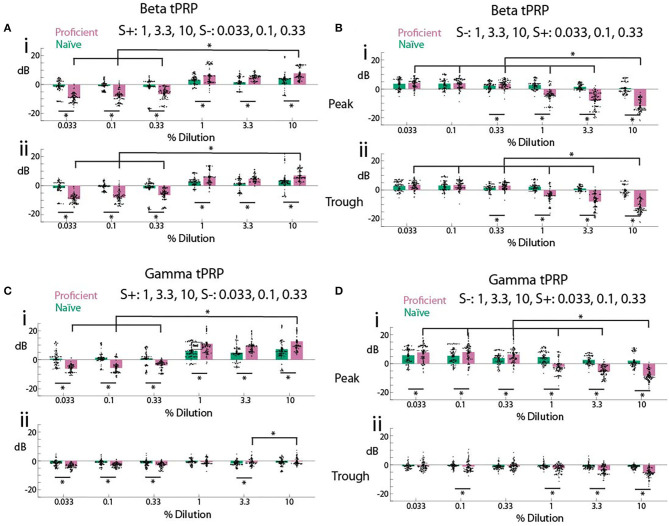
Summary of theta phase-referenced power. (A,B). Beta tPRP. (C,D) Gamma tPRP. Top panels (i) are referenced to the peak of the theta oscillation while bottom panels (ii) are referenced to the trough. (A,C) are tPRP for sessions where the three highest dilutions were the rewarded odorant while B and D are tPRP for sessions where the three lowest dilutions were the rewarded odorant. tPRP is shown for naïve mice (percent correct behavior ≤ 65%, green bars) and proficient mice (>80%, magenta bars). For the beta tPRP (A,B) a GLM yielded significant differences between rewarded vs. unrewarded stimuli, proficient vs. naïve and high dilution rewarded vs. low dilution rewarded (p < 0.001, 5,568 observations, 5,552 d.f., F-statistic = 525, p < 0.001, nine mice), and there was no statistical significance between peak and trough tPRP (p > 0.05, 5,568 observations, 5,552 d.f., F-statistic = 525, p < 0.001, nine mice). For the gamma tPRP (C,D) a GLM yielded significant differences between rewarded vs. unrewarded stimuli, proficient vs. naïve, high dilution rewarded vs. low dilution rewarded and peak vs. trough (p < 0.001, 5,568 observations, 5,552 d.f., F-statistic = 525, p < 0.001, nine mice). Asterisks show significant differences in a post-hoc t-test or ranksum test with p-values < pFDR. pFDR was 0.044 for peak beta tPRP, 0.043 for trough beta tPRP, 0.043 for peak gamma tPRP and 0.029 for trough gamma tPRP. The only comparisons that are shown are between the highest cliq and all other cliq and between naïve and proficient for each cliq.